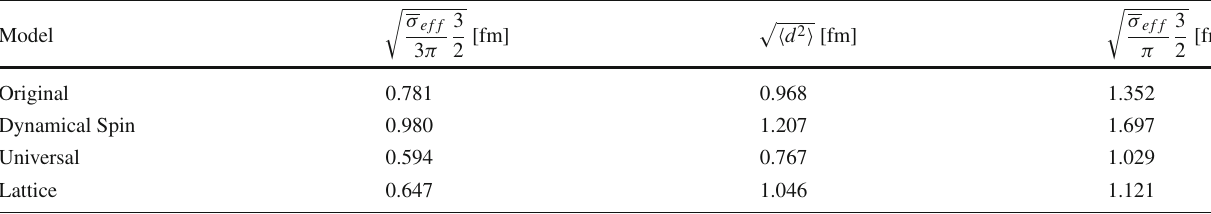
Table 4 Check of the validity of the RC inequality (20) in 3-dimension